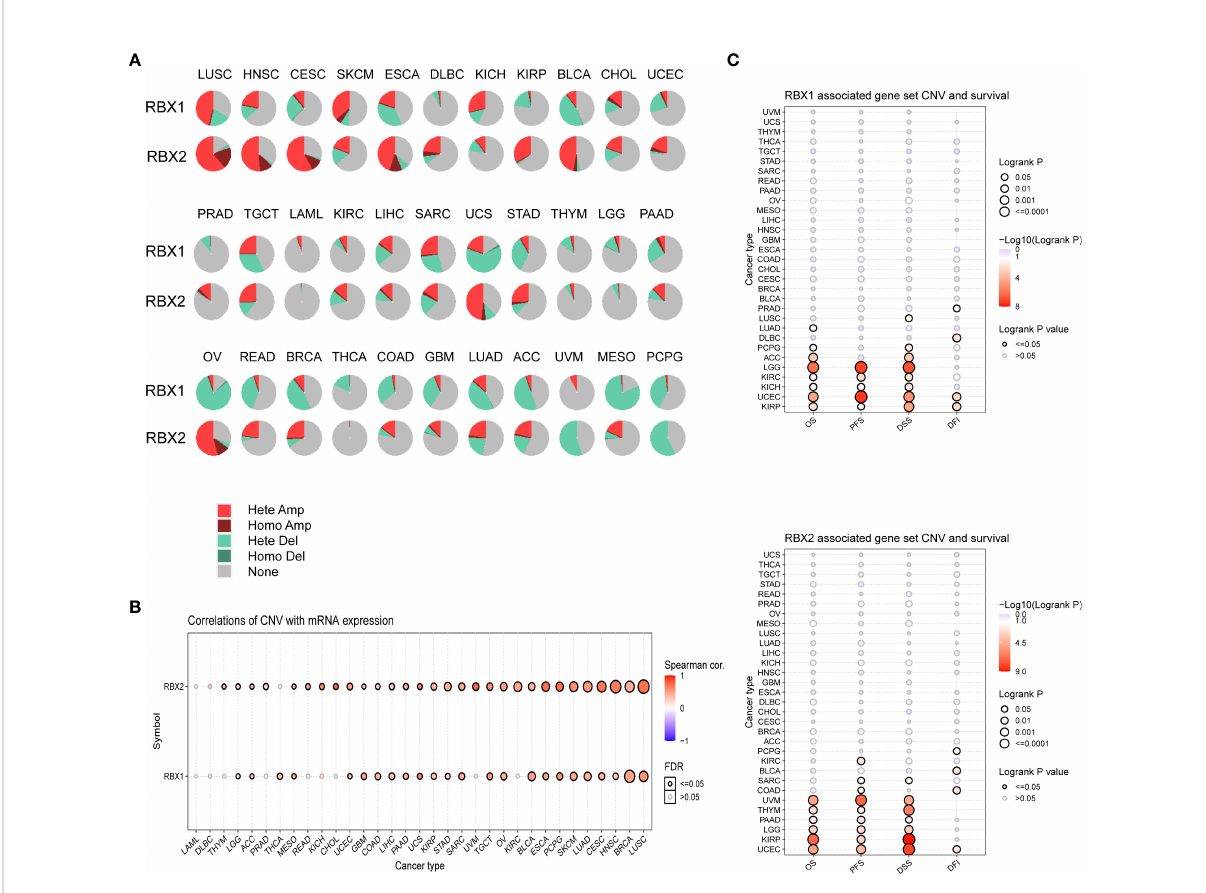
FIGURE 5 The CNV landscape of RBX1/2 in pan-cancer based on GSCA. (A) The deletion/ampli fi cation of heterozygous/homozygous CNV for RBX1/2 in pan-cancer. (B) Correlation between CNV and RBX1/2 mRNA expression in various cancers. (C) The pro fi le of survival between RBX1/2 associated gene set CNV groups in various cancer types. CNV, copy number variation; GSCA, Gene Set Cancer Analysis; Hete Amp, Heterozygous Ampli fi cation; Homo Amp, Homozygous Ampli fi cation; Hete Del, Heterozygous Deletion; Homo Del, Homozygous Deletion; OS, overall survival; PFS, progression-free survival; DSS, disease speci fi c survival; DFI, disease-free